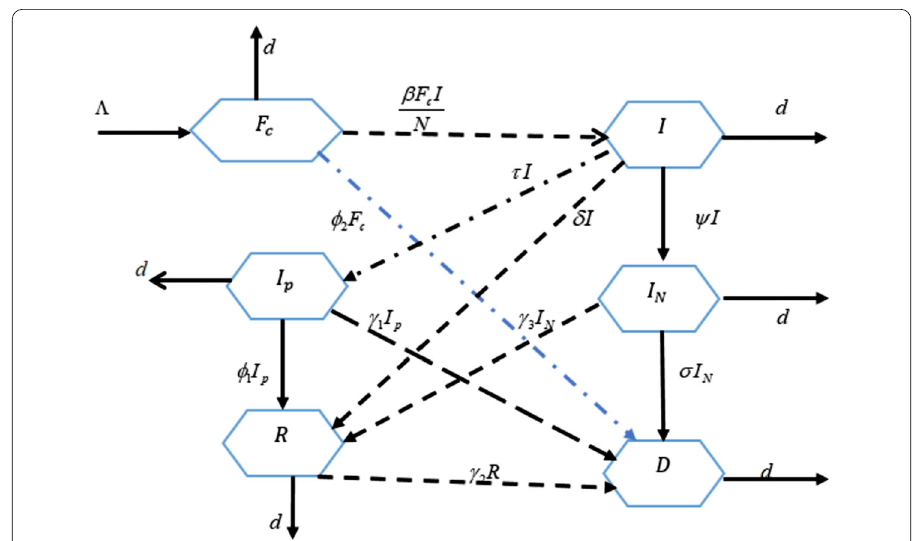
Figure 1 Diagram summarizing the survival of fractional calculus